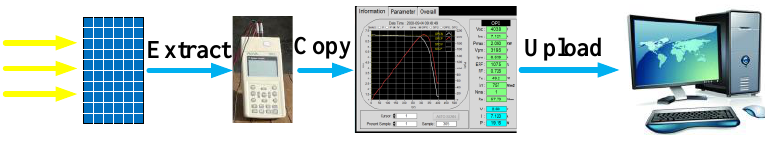
Figure 10. Traditional fault diagnosis process.